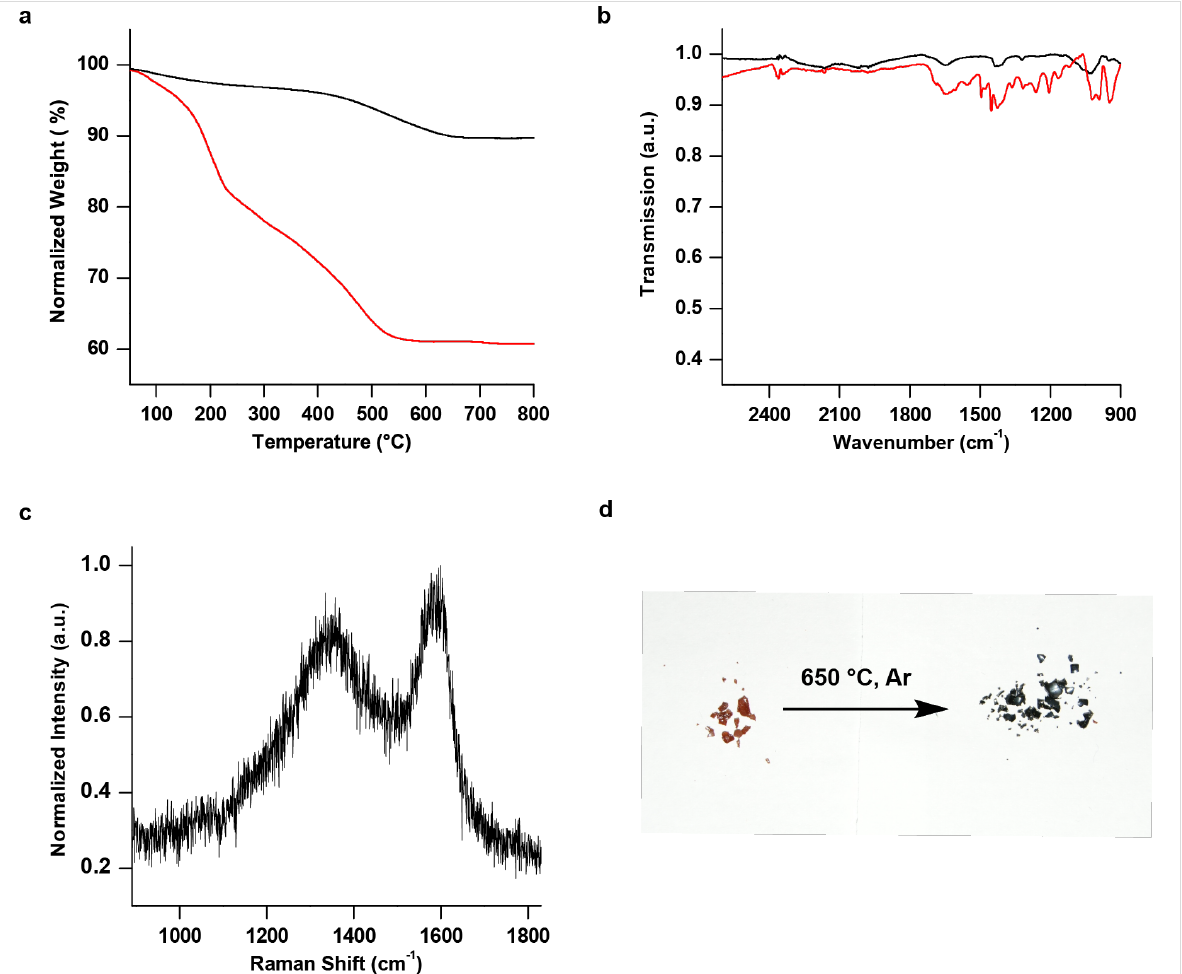
Figure 4: a) TGA measurement of the particles coated with block copolymer and particles coated with carbon, measured under oxygen atmosphere with a heating rate of 5 °C/min. In red the functionalized particles before pyrolysis. The weight loss up to 200 °C indicates the presence of the solvent (benzyl alcohol) which was used for the preparation of the particles. A mass loss of 20% can be observed. The black curve shows the functionalized particles after pyrolysis. b) IR spectrum of pure TiO 2 particles (black) and the functionalized particles with the block copolymer on the surface (red). New bands are visible from 1685 cm − 1 to 1166 cm − 1 attributed to the block copolymer, showing their presence on the surface. c) Raman spectrum of pyrolyzed particles, showing the D-Band (1355 cm − 1 ) and G-band (1584 cm − 1 ), which proves the carbonaceous structure. d) Picture of the functionali- zed particles before (brown) and after pyrolysis